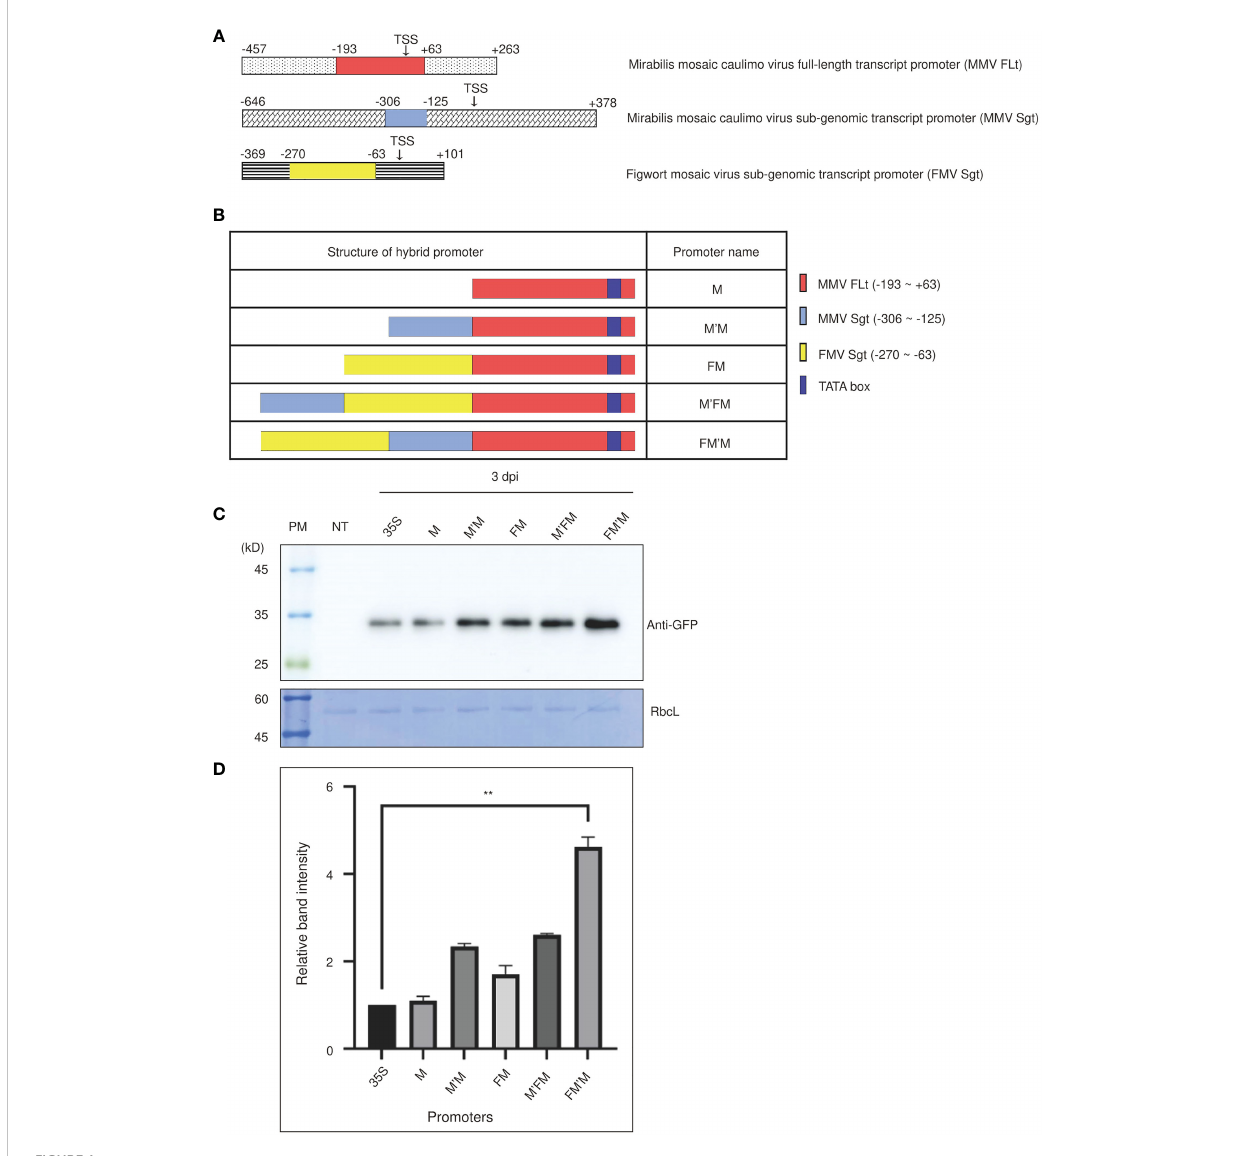
FIGURE 1 An arti fi cial FM ′ M promoter generated by fusing fragments from three viral promoters induces strong expression of reporter genes in tobacco ( Nicotiana benthamiana ). (A) The promoter regions used to generate the FM ′ M promoter. The different regions making up the FM ′ M promoter are indicated in the full- length promoters of MMV FLt (M), MMV Sgt (M ′ ), and FMV Sgt (F). Transcription start sites (TTS) are indicated. The numbers are the positions of nucleotide in the promoter; + and – indicate the downstream and upstream regions relative to the TTS, respectively. (B) Schematic presentation of hybrid promoters. The dark blue box indicates the TATA box. (C, D) Expression levels of the GFP reporter. The reporter constructs consisting of the indicated promoters and the reporter gene GFP were introduced into tobacco ( N. benthamiana ) leaf cells via Agrobacterium -mediated in fi ltration. Leaf tissues were harvested at 3 dpi. (C) Total soluble proteins from leaf tissues at 3 dpi were analyzed by western blotting using anti-GFP antibody. An identical membrane was stained with CBB; RbcL was used as a loading control. PM: protein size standard; NT: wild-type plant without in fi ltration; 35S: CaMV 35S promoter. (D) To quantify the GFP levels at 3 dpi, the band intensities were measured using the LAS-3000 imaging system. GFP levels from hybrid promoters are shown as values relative to that produced by the CaMV 35S promoter. Data shown are means ± SE (n = 3); asterisks indicate statistically signi fi cant differences determined by one-way ANOVA followed by Dunnett ’ s multiple comparison test; **: P <